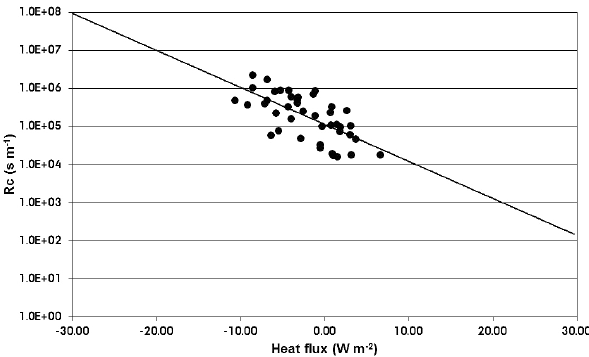
Fig. 7. The relation between the calculated Rc and the measured heat flux. The correlation coefficient R 2 is ∼